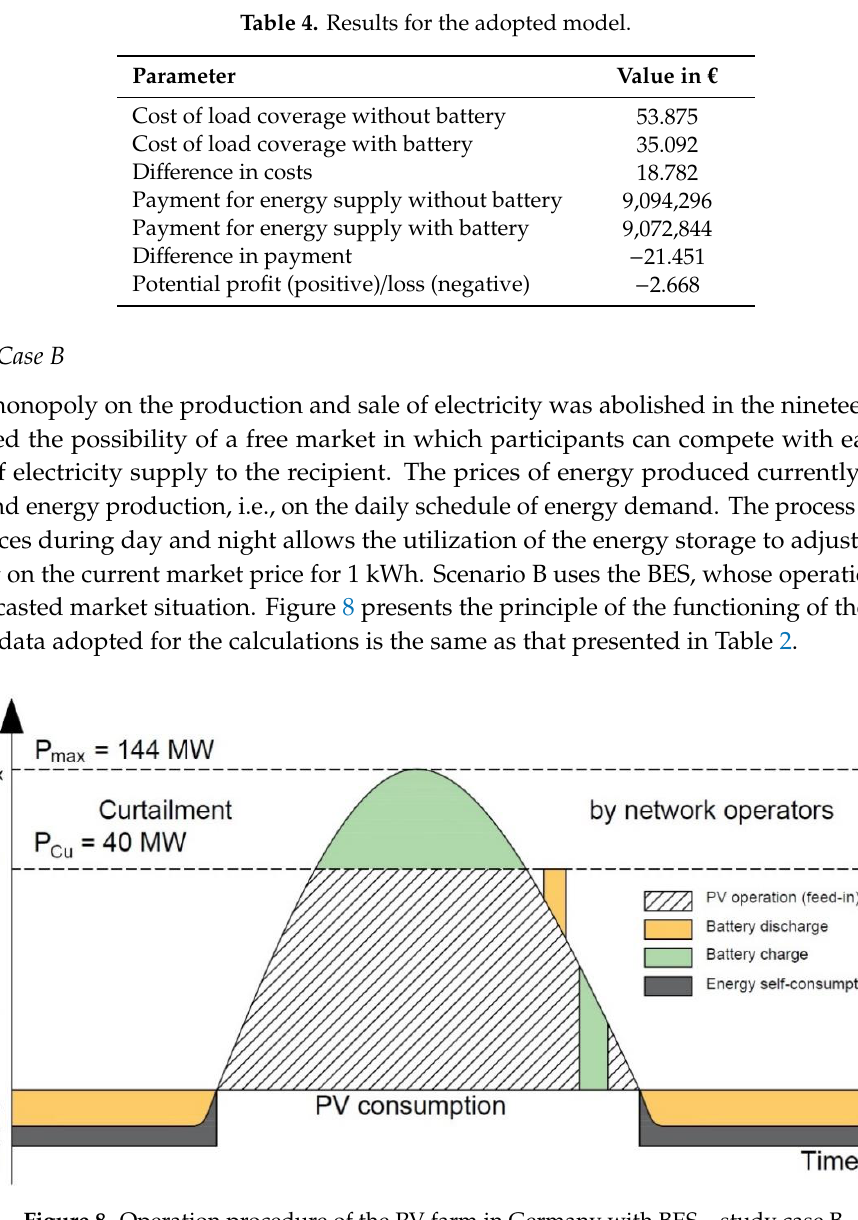
Figure 9. Control algorithm for the adopted model.